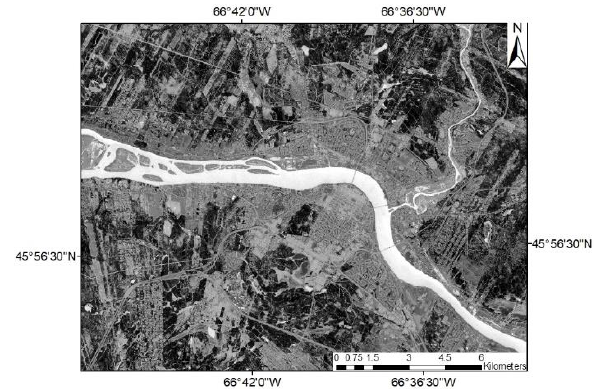
Figure 1. NDWI showing the water extent before the flood